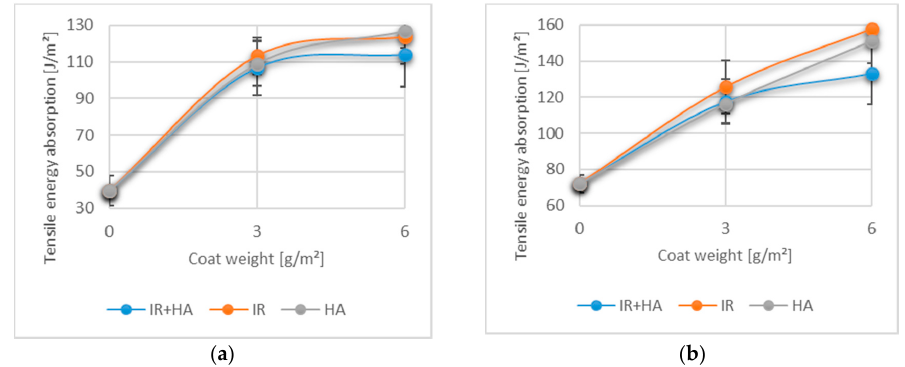
Figure 4. Tensile energy absorption (TEA) of paper coated with 3 g/m 2 (1 layer) and 6 g/m 2 (2 layers) of chitosan: ( a ) TEA for machine direction (MD); ( b ) TEA for cross direction (CD). ( n = 15).